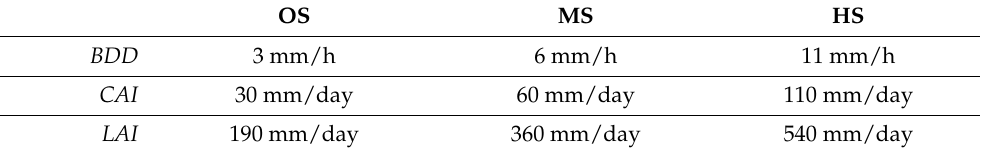
Table 2. BDD, CAI and LAI thresholds for Ordinary (OS), Moderate (MS) and High Stress